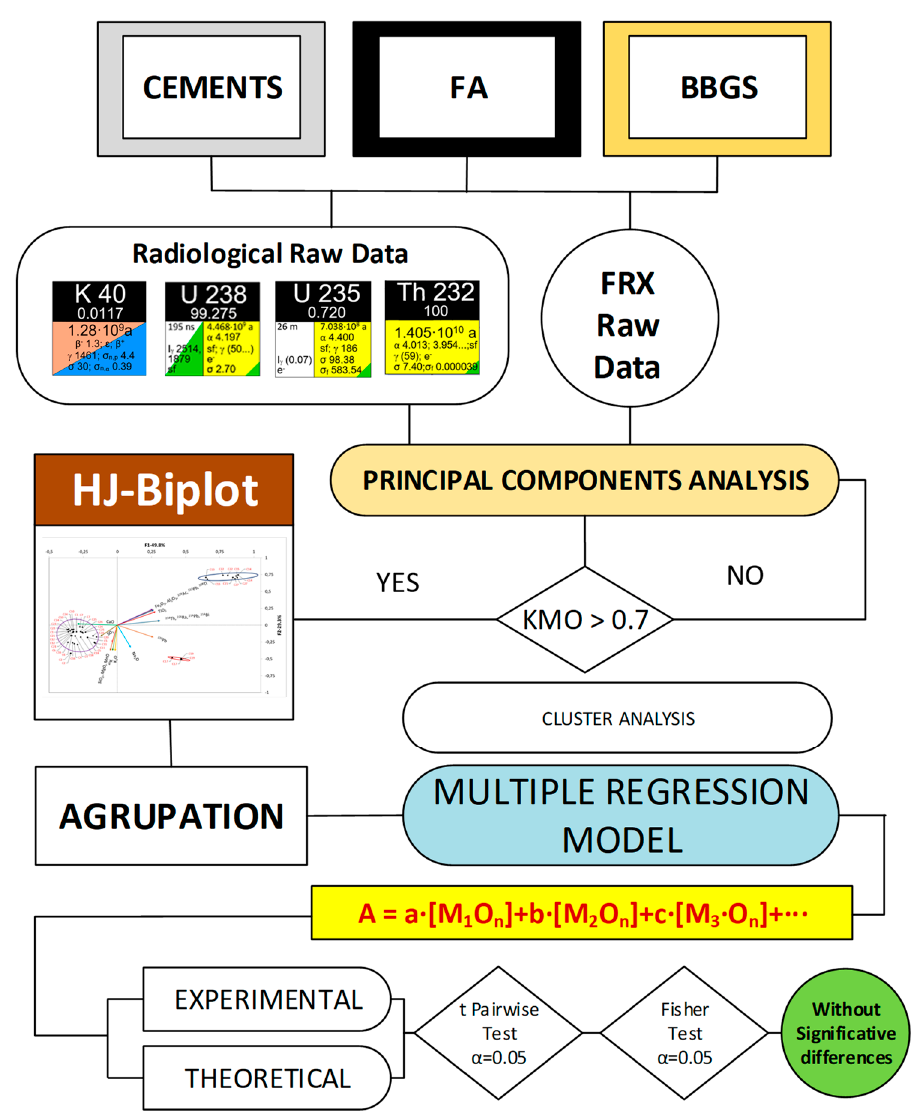
Figure 1. Diagram of the statistical process applied to the activity concentrations and chemical compositions obtained by XRF.